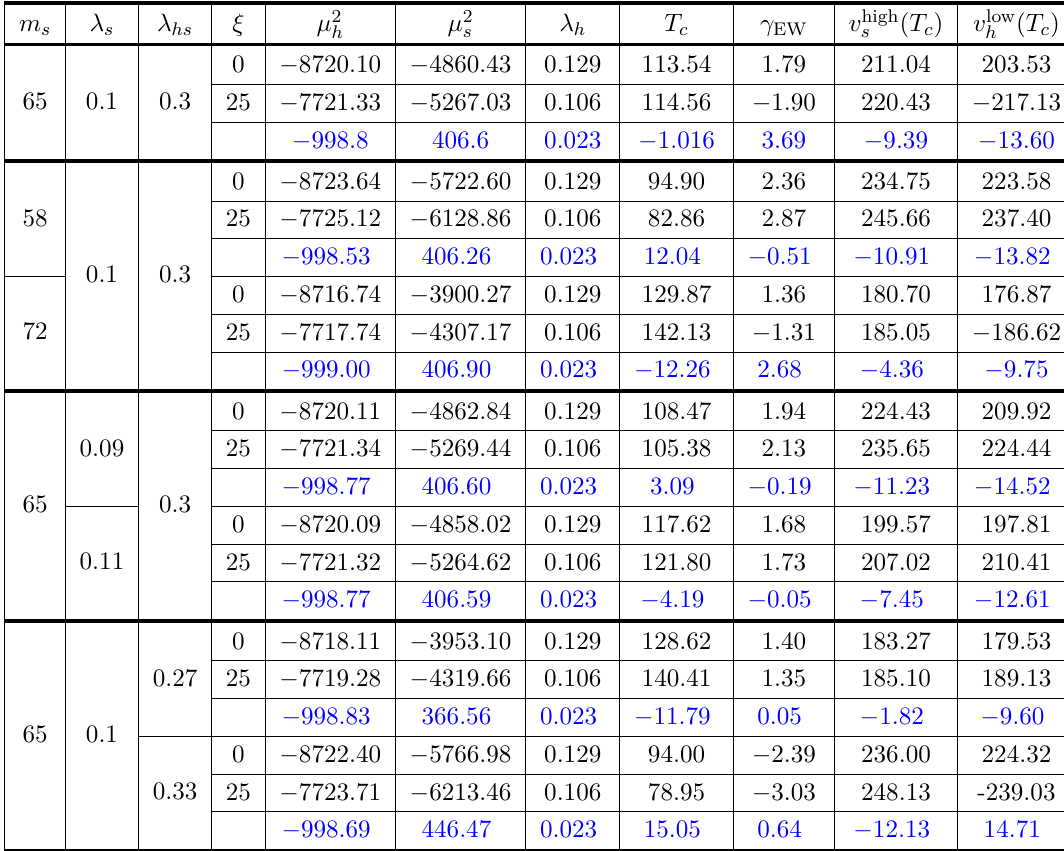
Table 2 . Values of Lagrangian parameters, critical temperature, γ EW , and VEVs for points around the benchmark point in the MS + GC_SelfEnergy_Sol scheme. All dimensionful quantities are in GeV or GeV 2 . The blue numbers show difference between quantities evaluated at ξ = 0 and